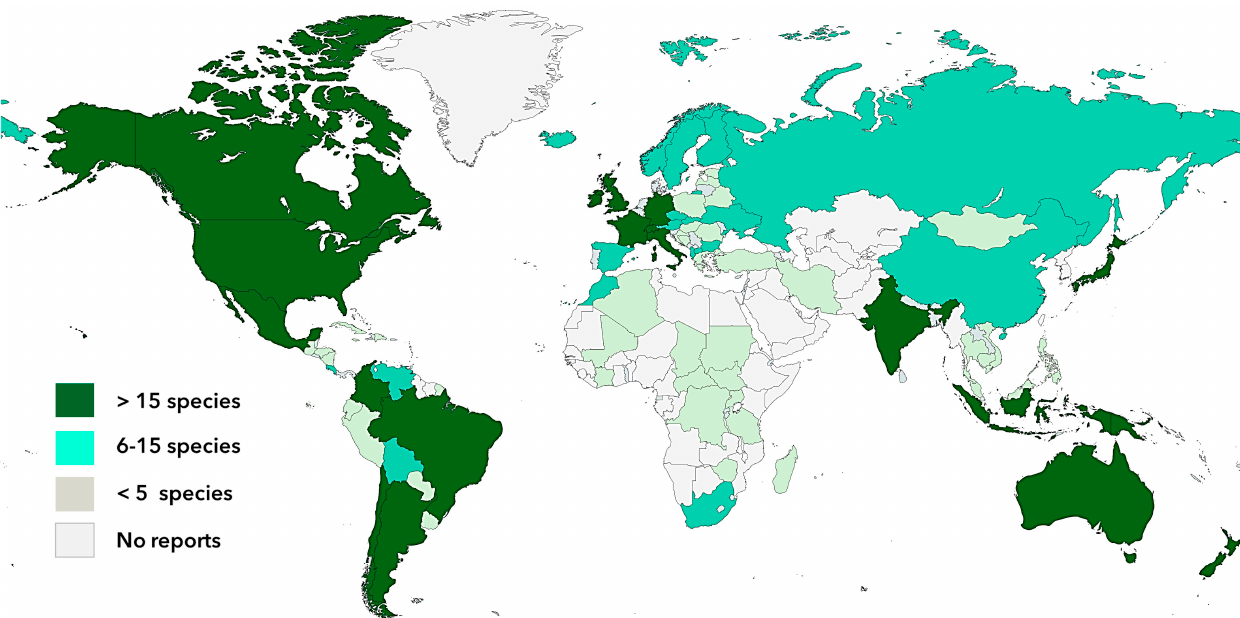
Figure 2. World geographic distribution and diversity of psychoactive mushrooms.